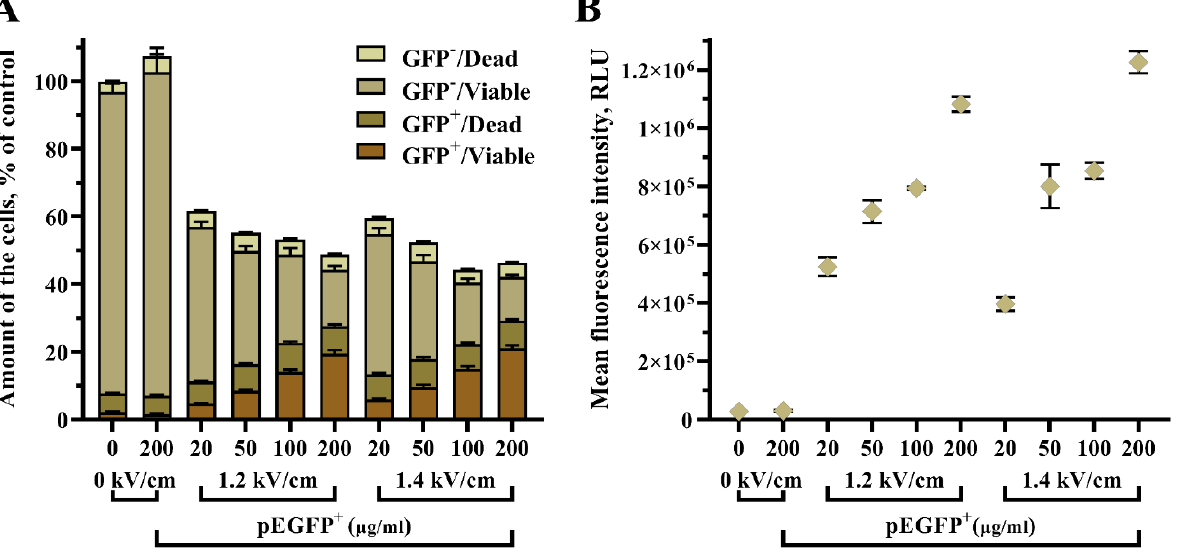
Figure 5. The impact of pEGFP plasmid concentration for the GET efficiency in UT-7 cells, where transfected/viable cells are denoted as (GFP + /Viable), transfected/dead as (GFP + /Dead), untrans- fected/viable as (GFP − /Viable), and untransfected/dead as (GFP − /Dead) shown in stacked bars. The overall cell number in the sample is shown as column height ( A ). The pEGFP fluorescence intensity is represented by a scatter dot plot ( B ). The X-axis depicts pulse strength in kV/cm. The data points are shown as mean ± SD from two independent experiments performed in quadruplicate and were further analyzed using one-way ANOVA with Tukey’s multiple comparisons test. All statistical re- sults are presented in the Supplementary file (Table S3).